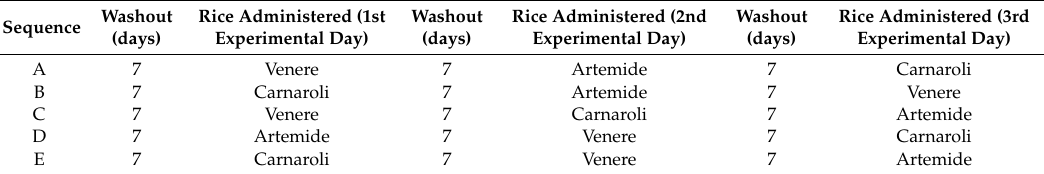
Table 1. Sequential steps of study interventions.